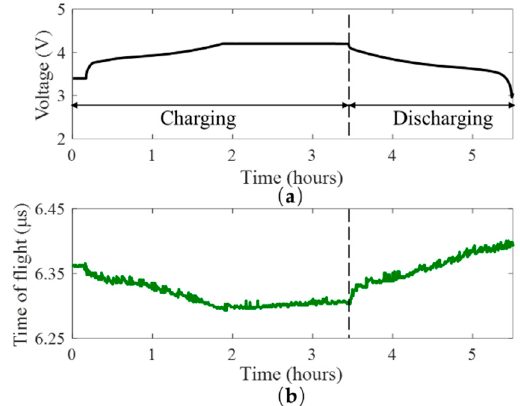
Figure 6. ( a ) Voltage data during a C/2 charging and discharging cycle, ( b ) corresponding evolution TOF taken every 20 of TOF taken every 20 s.